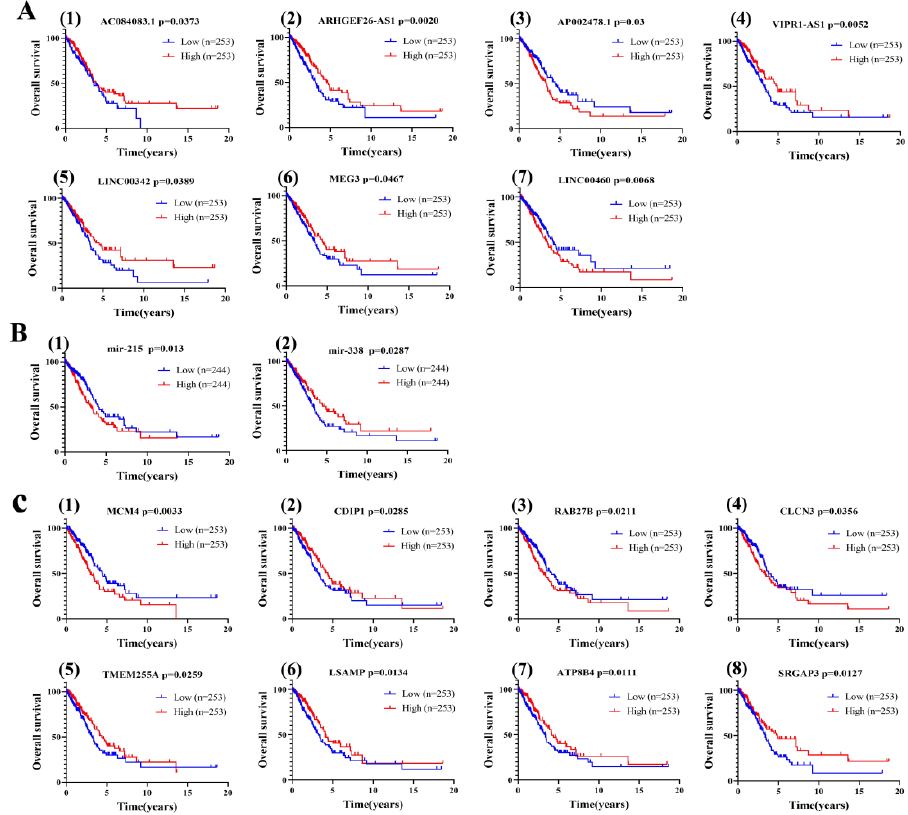
Figure 3. Correlation analysis of differentially expressed RNAs in ceRNA network with overall survival of LUAD patients by a Kaplan–Meier survival curve. ( A ) lncRNAs. ( B ) miRNAs. ( C ) mRNAs. Statistically significant differences between the two groups of data were estimated by the Mann– Whitney test. A p < 0.05 was considered statistically significant.